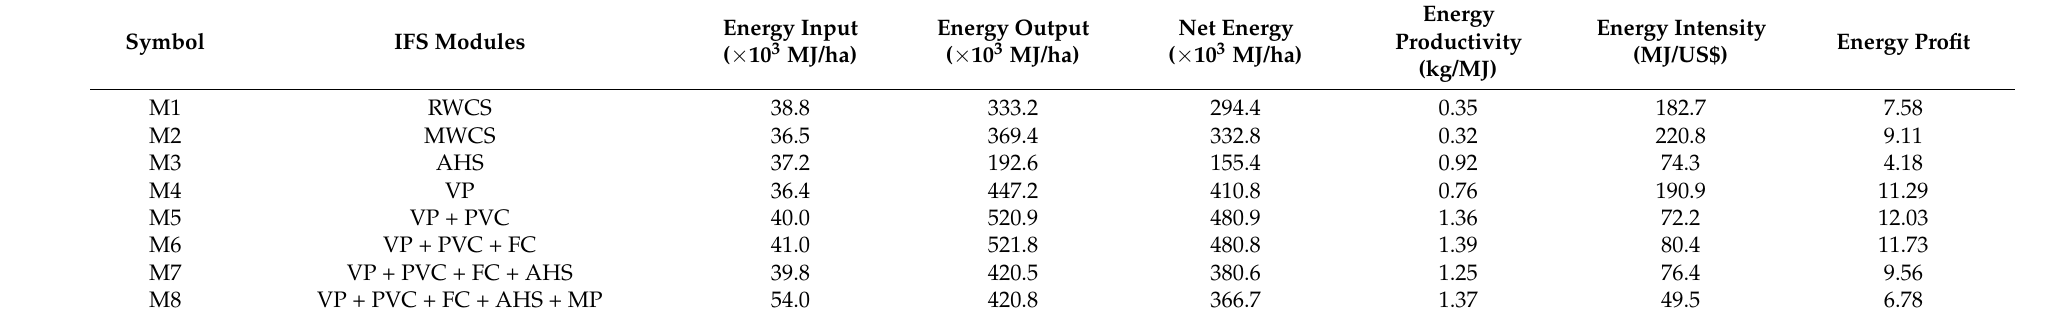
Table 8. Energy output, input and net energy (MJ/ha), energy productivity (kg/MJ), intensity (MJ/ ₹ ) and profitability under diverse modules of the integrated farming